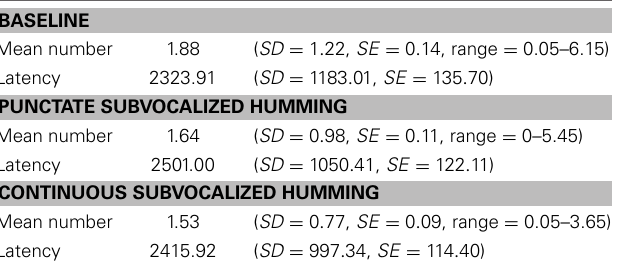
Table 1 | Mean number of occurrences of unintentional subvocalizations per trial and mean latencies (ms) of first subvocalization as a function of condition.